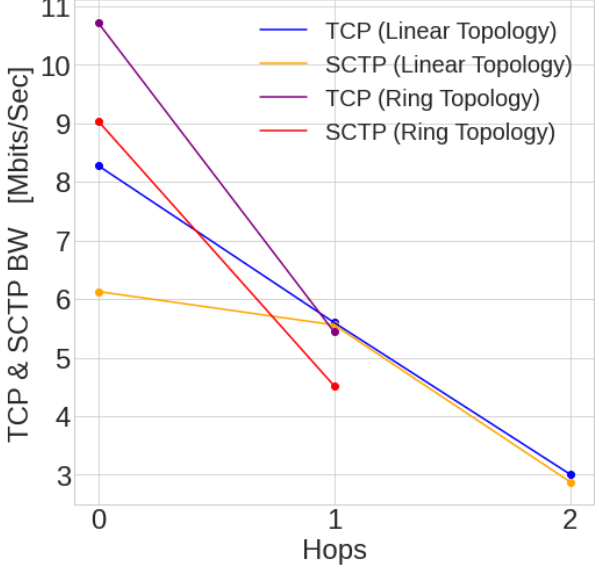
Figure 17. POWDER lab TCP and SCTP bandwidth.